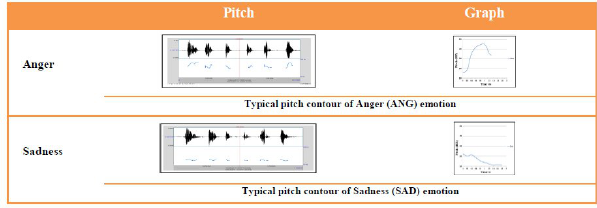
Fig. 8. American pitch contours for, Anger and Sadness.